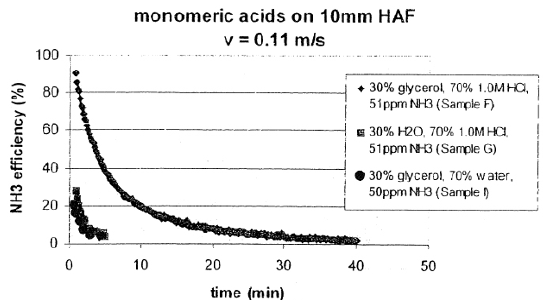
Figure 11. Off-gassing of ammonia from acid treated HAF.